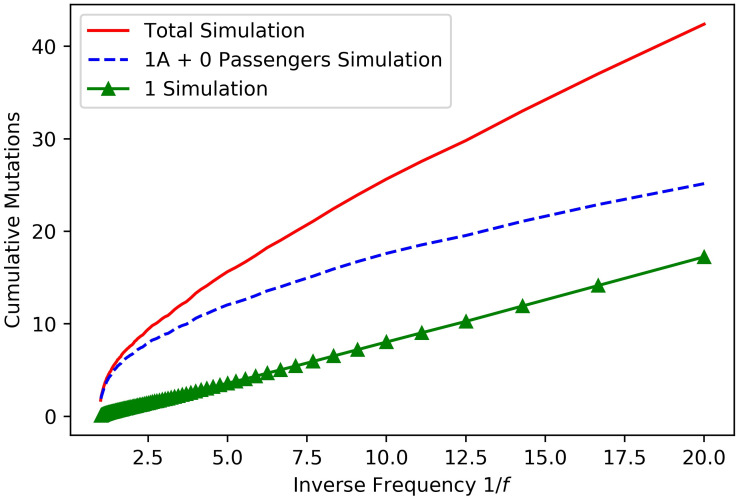
Site frequency spectrum in the type 1 population.The figure shows the contribution of the different mutation types to the site frequency spectrum. The simulation was performed with parameters ν = 0.02, u1 = 2 × 10−4, λ0 = 0.02, λ1 = 0.04 and a0 = a1 = 1 and is the average site frequency spectrum of 1000 runs. We simulated the 1A families and type 0 passenger mutations on their founders. Then, we obtained type 1 mutations for each 1A family by applying (8) in Methods. We only consider mutations present in the type 1 population because, as t → ∞, the proportion of the population that is type 0 cells approaches 0. As suggested from Theorem 2, the type 1 site frequency spectrum is linear when plotted against 1/f. The 1A + 0 line looks similar to a power law, as suggested by (4).